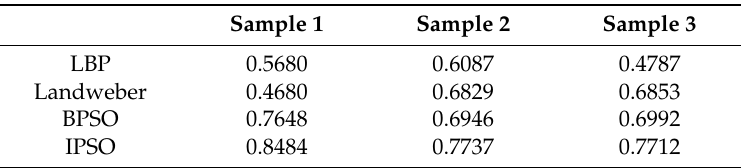
Table 2. Relative image error